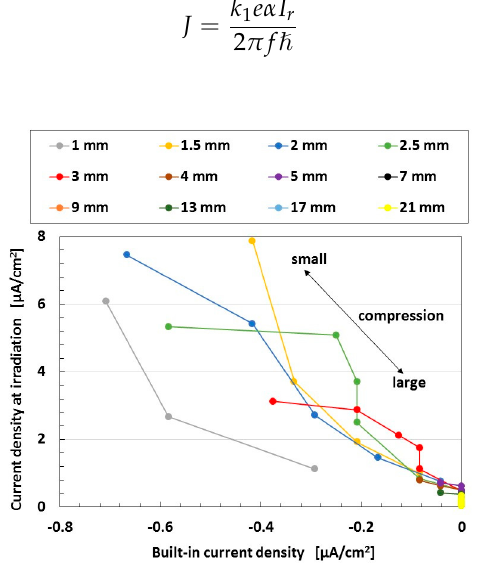
Figure 6. Relation between current density at irradiation and built-in current density under compression and elongation under ultraviolet light for a wet-type MCF rubber solar cell electrolytically polymerized under a magnetic field with 0.22 g of Ruthenium complexes dye and 7.4 g of KI+I 2 electrolyte. The MCF rubber had 3 g of TiO 2 , 6 g of Ni, 4.5 g of MF, and 9 g of NR-latex. The irradiation light was ultraviolet (40 lx). The experimental apparatus and procedure were the same as those used in the second report [19].